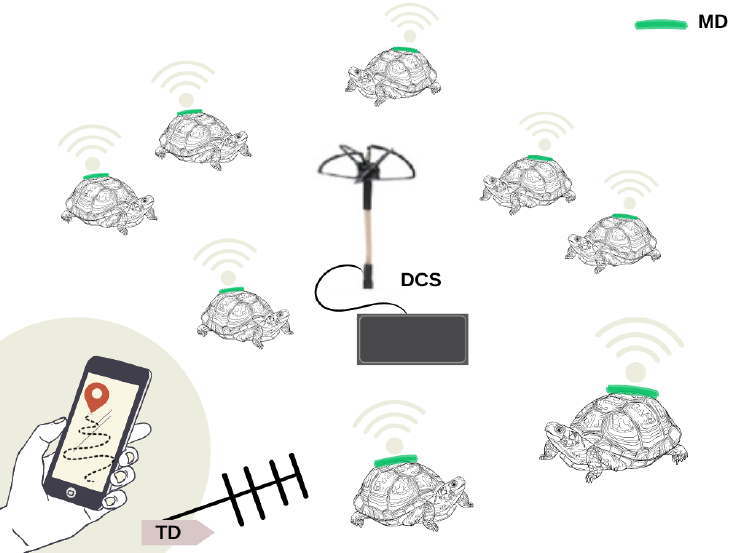
Figure 1. Schematic diagram showing the family of interacting devices: the monitoring device on individuals (MD), the data collector station (DCS), and the tracking device